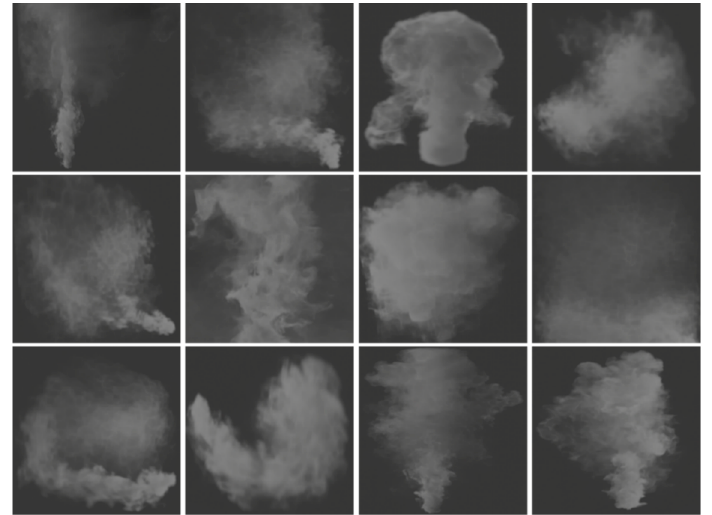
Figure 1. Sample images of virtual smoke.